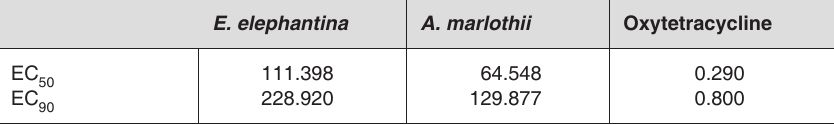
TABLE 2 Effective concentrations ( μ g/m l ) of E. elephantina and A. marlothii leaf extracts which suppress 50 % and 90 % of E. ruminantium in cell cultures compared to pure oxytetra- cycline derived by linear regression from the logarithmic dose-response